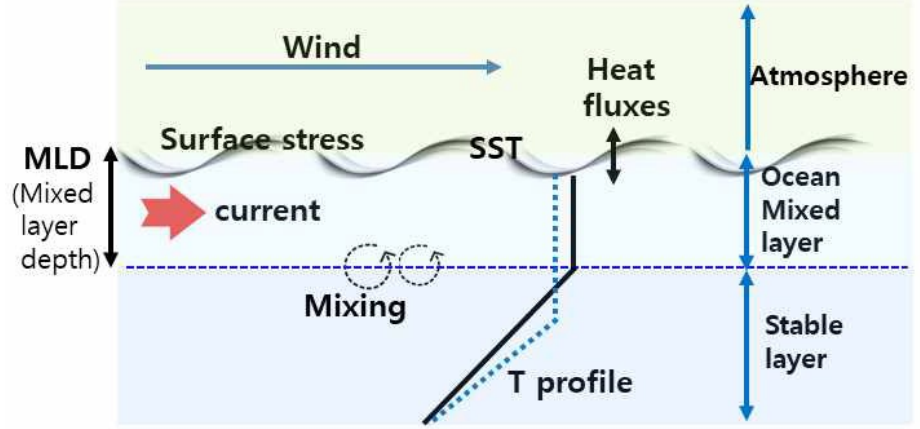
Figure 3. Schematics of the one-dimensional ocean mixed layer (OML) model used for the WRF model.